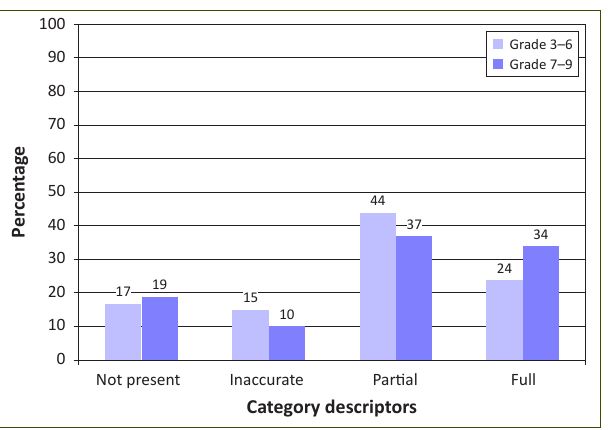
FIGURE 3: Conceptual explanations of learners’ correct answers by grade